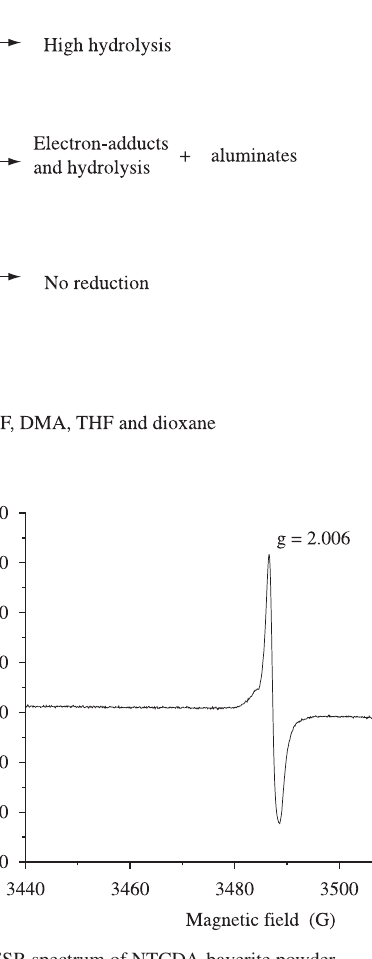
Figure 4. X-ray diffraction pattern of NTCDA-bayerite powder. Figure 5. ESR spectrum of NTCDA-bayerite